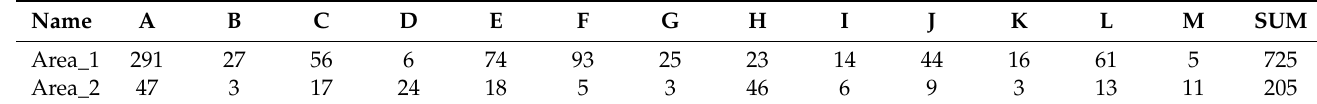
Table 1. Number of functional blocks (A: Residential area, B: Administrative office land, C: